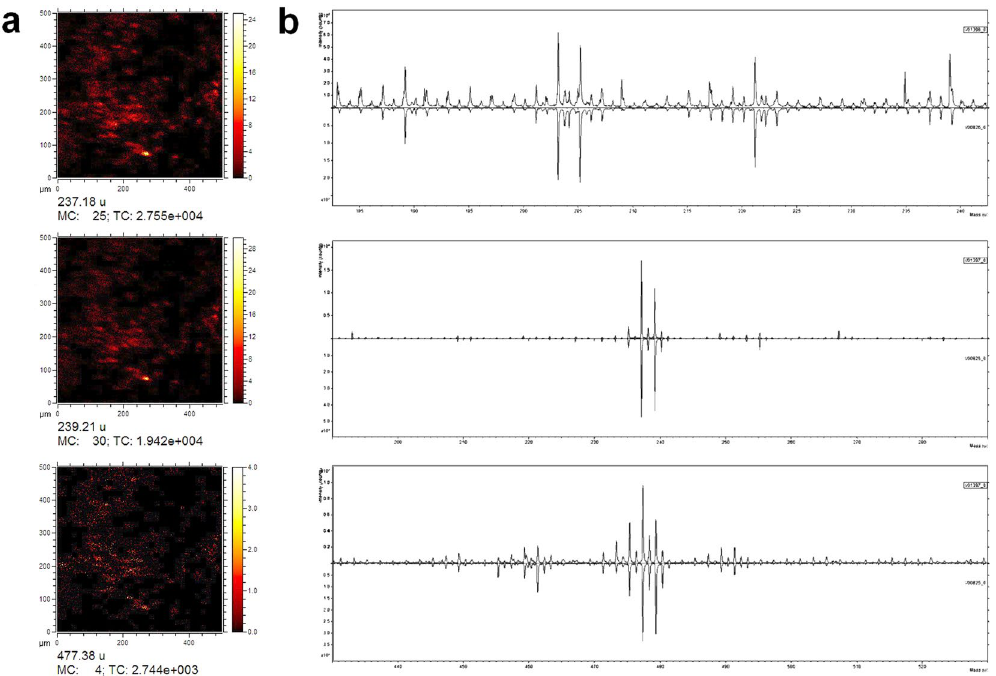
Figure 8. ToF-SIMS, recorded on another fragment of the sediment shell which is shown in Fig. 7. ( a ) Maps (500 * 500 μ m 2 ) for 237, 239 and 477 mass units (negative polarity, MC = maximum counts per pixel, TC = total counts). ( b ) Selected sections of mass spectra from the sediment shell (up) versus those of the HBA reference (down): top (80–240 u, positive polarity), center (190–290 u, negative polarity), bottom (430–530 u, negative